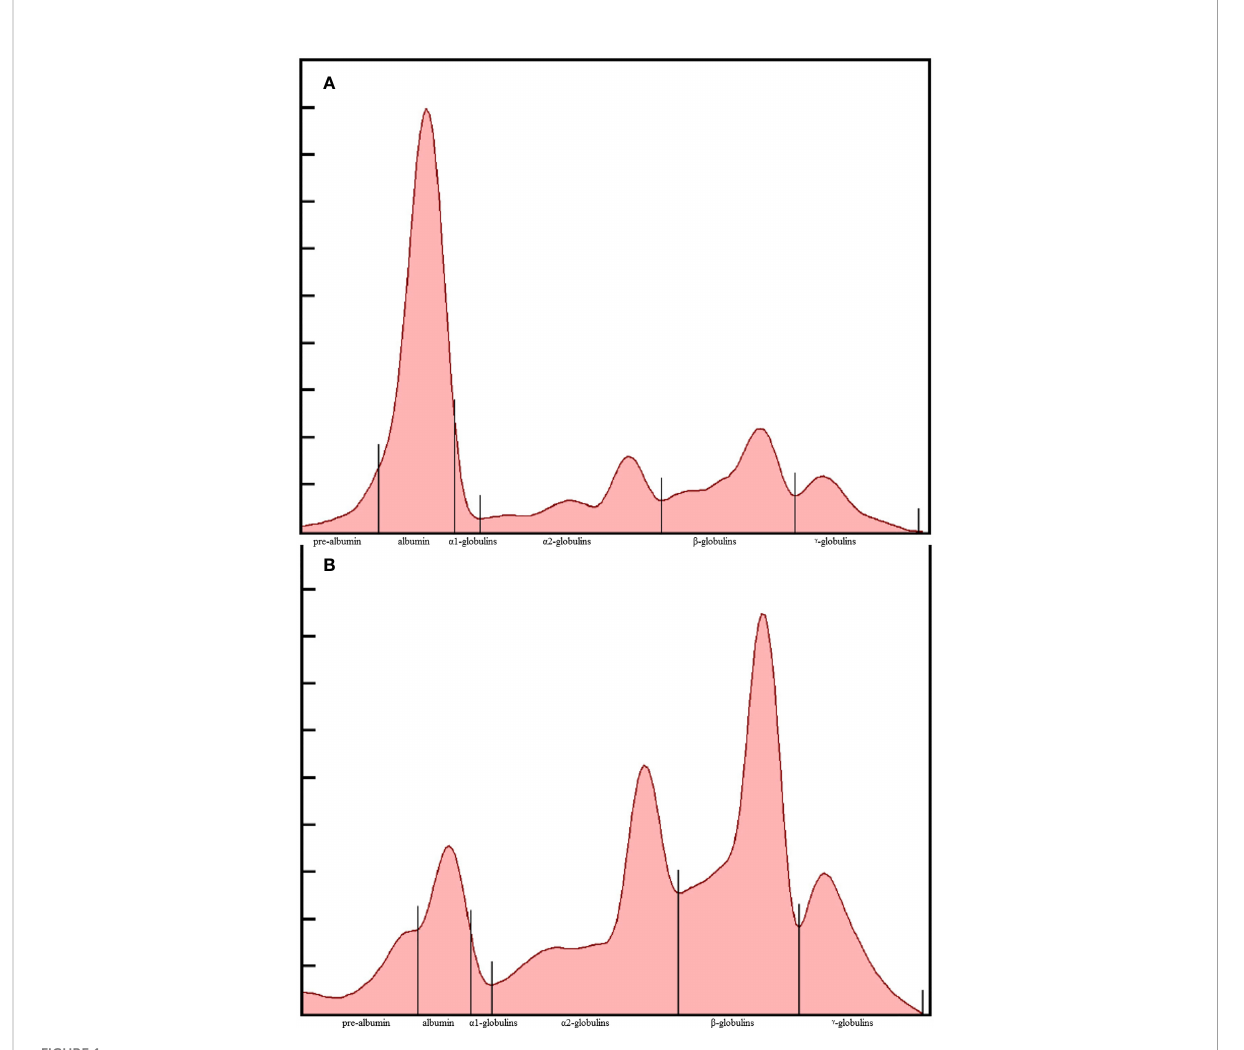
FIGURE 1 Representative plasma protein electrophoretograms of a clinically-normal (A) and Aspergillus- diseased African penguin ( Spheniscus demersus ) (B) . The fractions, from left to right, are prealbumin, albumin, a 1, a 2, b , and g -